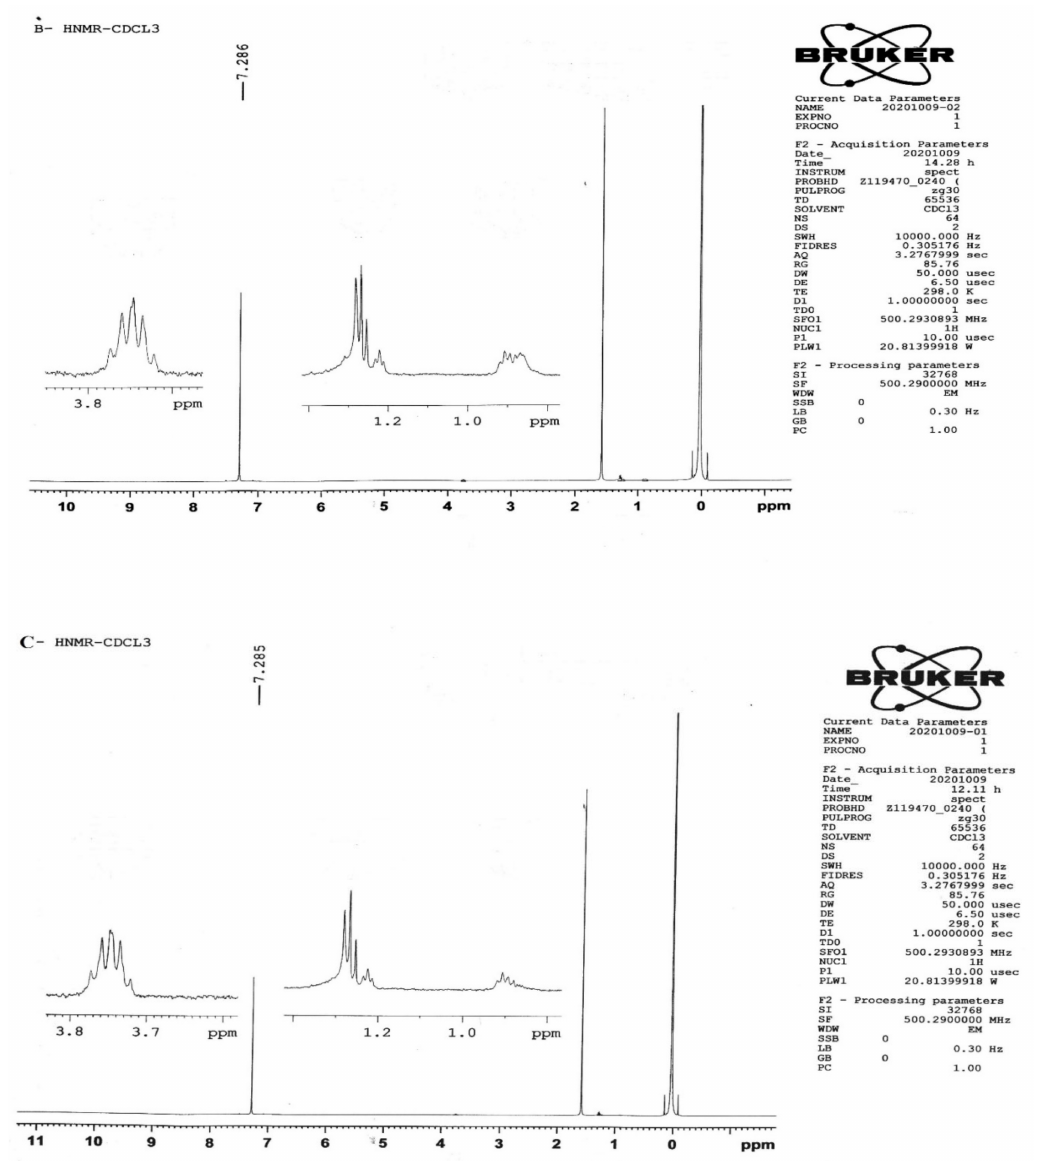
Figure 3. 1 H-NMR spectra of ( A ) pure chitosan, ( B ) pure FA, and ( C ) FA–CS